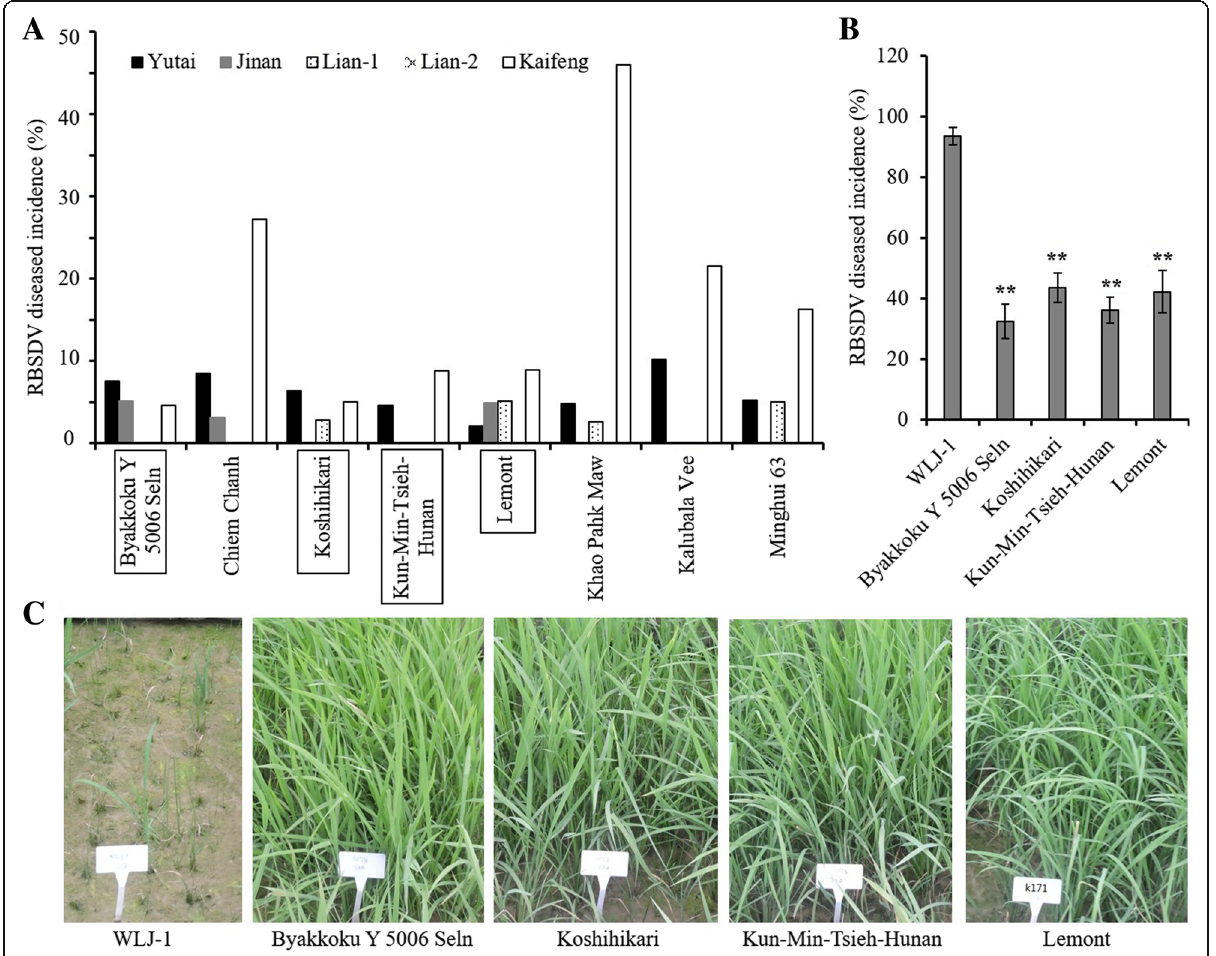
Fig. 2 Phenotypes of 4 identified RBSDV resistant varieties. a Phenotype comparison of the candidate RBSDV-resistance varieties among 5 locations. Rectangles highlight the newly identified resistant varieties with stable RBSDV resistance level. b and c Disease incidences ( b ) and images ( c ) of 4 RBSDV-resistance varieties and WLJ-1 control after artificial inoculation with RBSDV. ** P <0.01 by Student ’ s